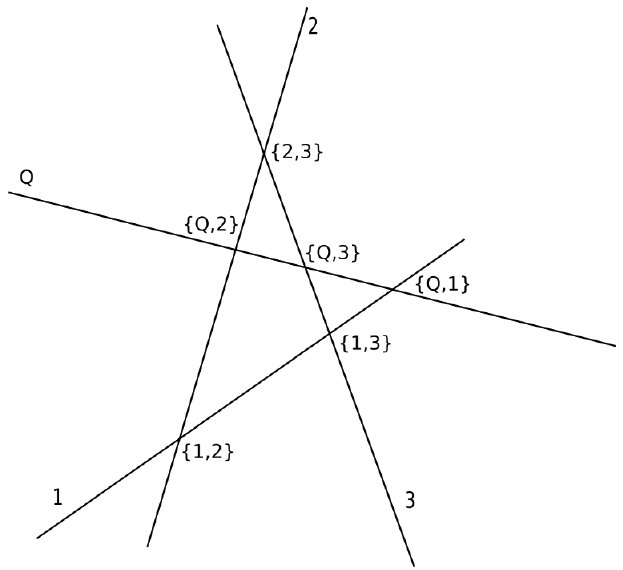
Figure 8 . A collection of four boundaries, f 1 ; 2 ; 3 ; Q g